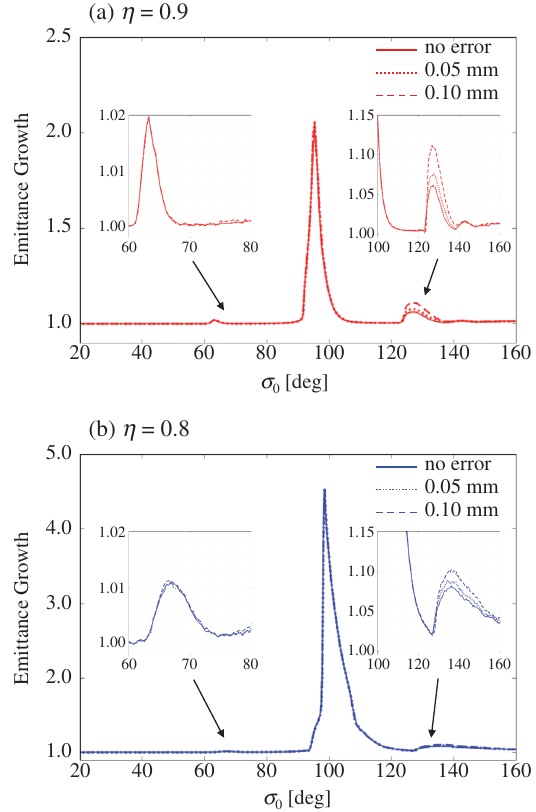
FIG. 4. W ARP simulation results in consideration of the rf-field property of the LPT. Nonlinear imperfection fields up to the sixth order have been introduced in these PIC simulations. The strengths of the nonlinear fields are determined by analyzing the weak rf-potential distortion caused by misalignments of the four quadrupole rods. The upper picture corresponds to the case where η ¼ 0 . 9 while the lower to the case where η ¼ 0 . 8 . In each picture, we have considered two different sizes of rms misalign- ments; namely, 0.05 mm (dotted line) and 0.1 mm (broken line). The result in Fig. 2 under the ideal linear focusing condition is replotted with solid line for reference. The average nonlinear multipole strengths relative to the quadrupole ’ s are listed in Table 1 of Ref. [40] and assumed in these simulations. The rf